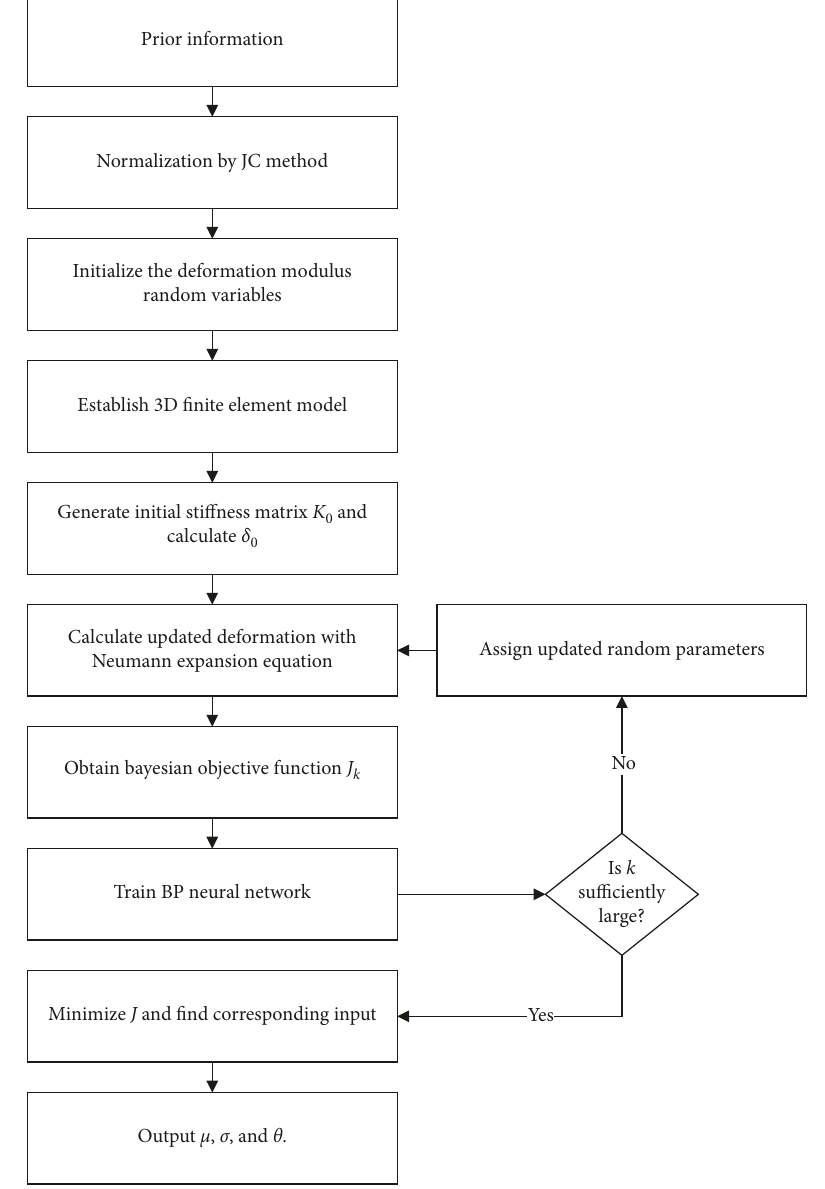
Figure 2: Stochastic inversion algorithm for concrete